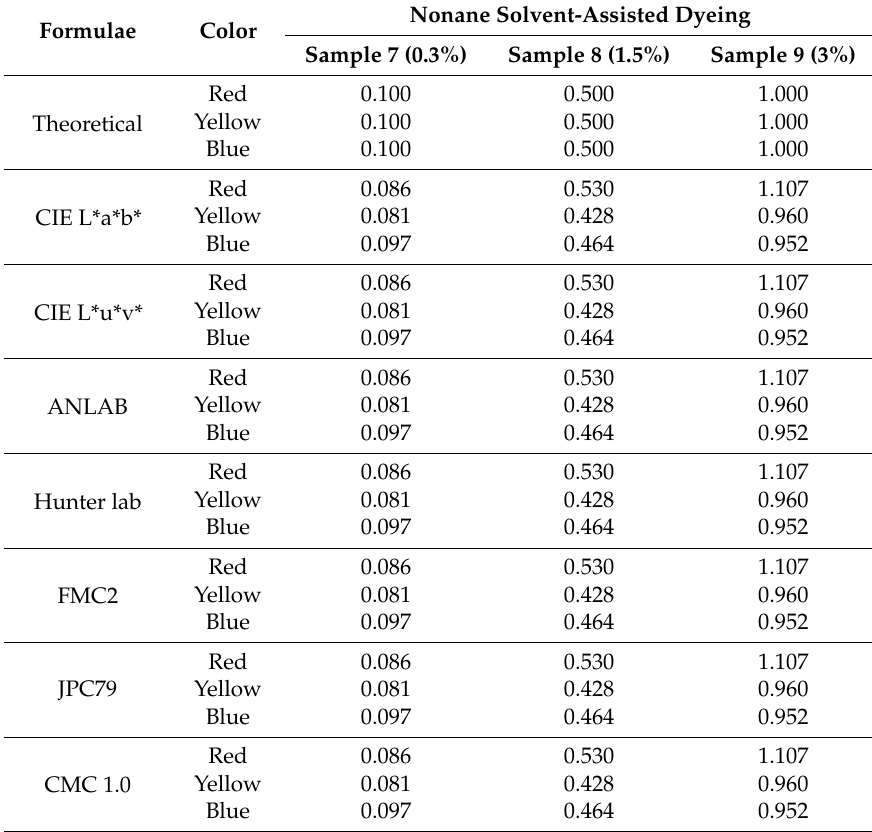
Table 9. Color-matching recipes of nonane-dyed standard wool